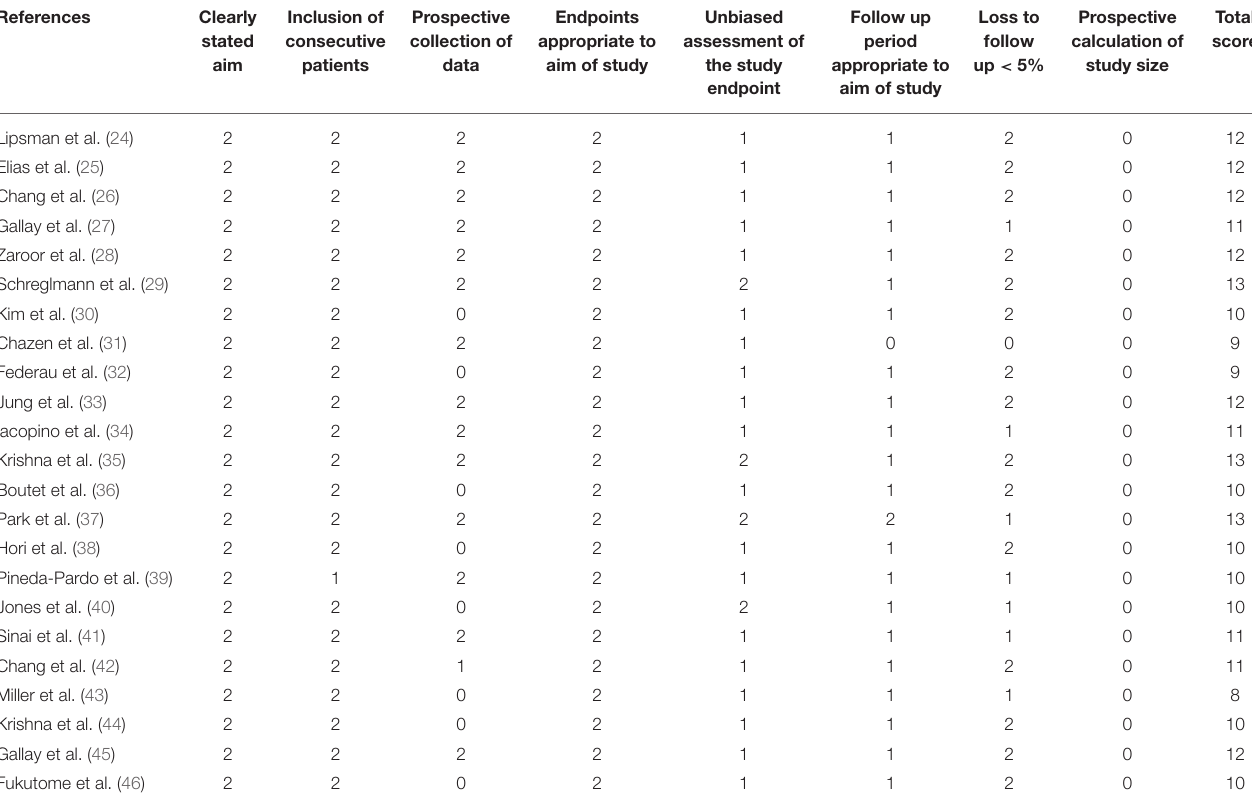
TABLE 1 | Methodological index for non-randomized studies (MINORS) scores for included